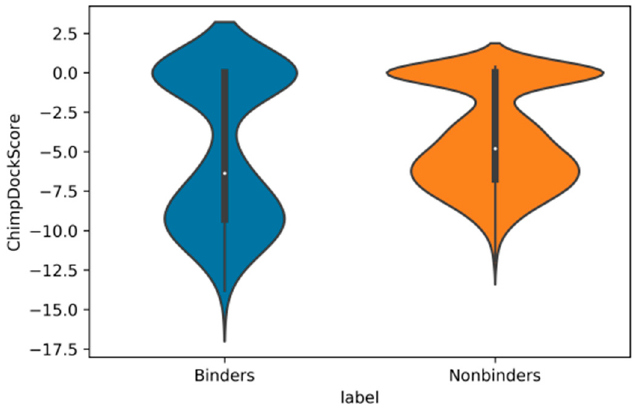
Figure 1. Violin plots of the distributions of docking scores (kcal/mol) with the chimp androgen receptor for binders ( blue ) and nonbinders ( orange ).